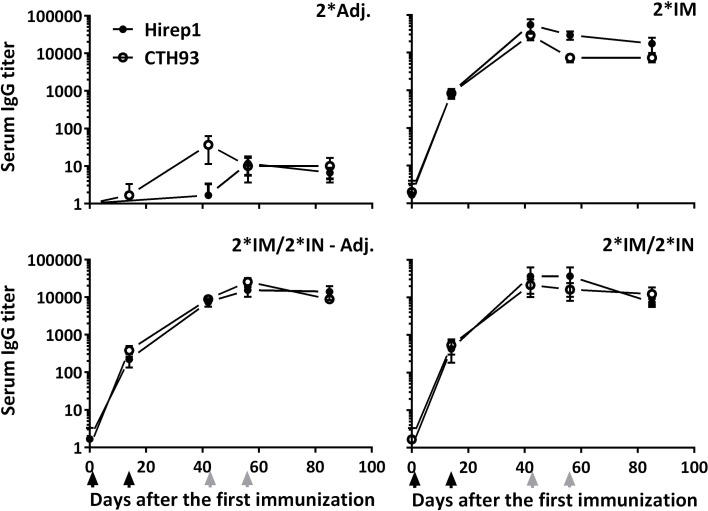
The kinetics of antigen-specific IgG in serum of vaccinated minipigs. Serum was collected at various timepoints during the immunization period and evaluated for Hirep1- and CTH93-specific IgG responses by ELISA. Graphs show mean ± SEM. The black arrows indicate the two IM immunizations and the two gray arrows indicate the two IN immunizations.